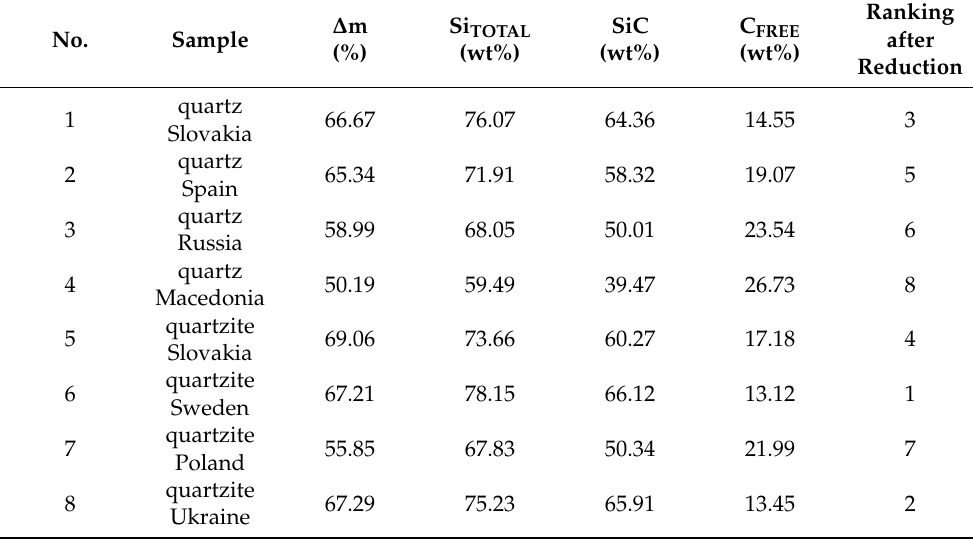
Table 6. Product parameters after carbothermic reduction test at 1800 ◦ C, 15 min (granular sample).